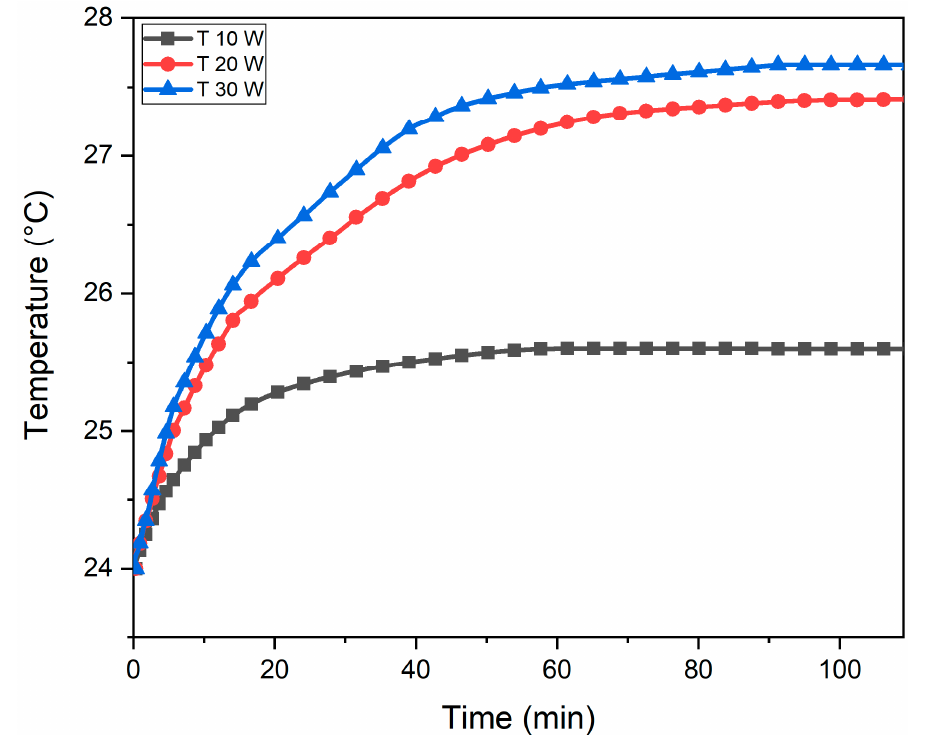
Figure 21. Effect of varying power level on axial flow configuration.